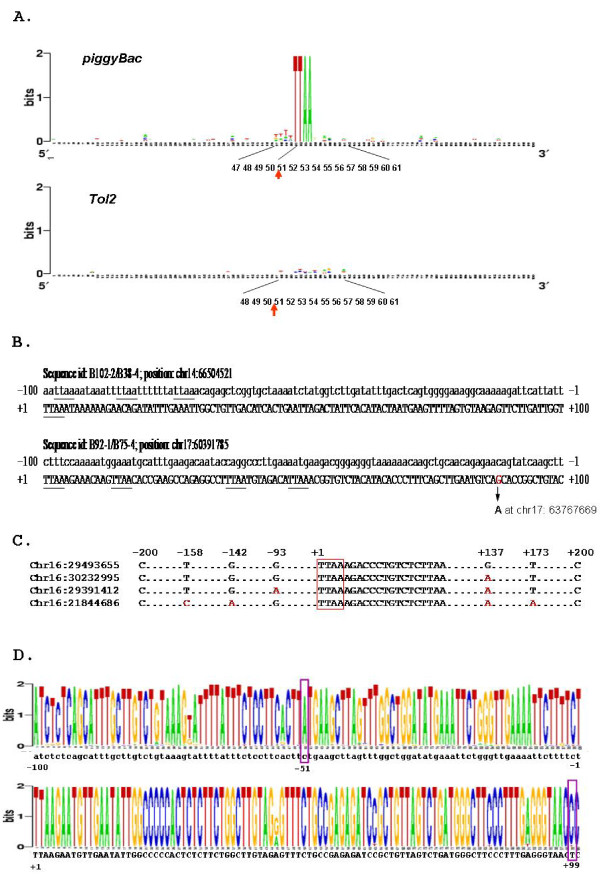
In-depth analyses of piggyBac and Tol2 target sequence preferences in HEK 293. A. The sequence logos of piggyBac and Tol2 target sites. B. Two representative sequences flanking the sites repeatedly targeted by piggyBac. The TTAA tetranucleotide are underlined. C. A sequence alignment of four sequences on chromosome 16 that share 100% sequence identity with the first 100 bp of the piggyBac target B89-4. The residue that is different from the other three sequences at a given position is indicated in red. Dots represent all the primary sequences that are identical in all four sequences. The numbers on the top indicate the relative position of residues. D. The sequence logo of 184 sequences that share at less 97% sequence identity with the piggyBac target, B87-4. Note: The chromosomal sequence 5' and 3' to the target site are in lower cases and upper cases, respectively. piggyBac transposon is inserted at the position between -1 and +1.